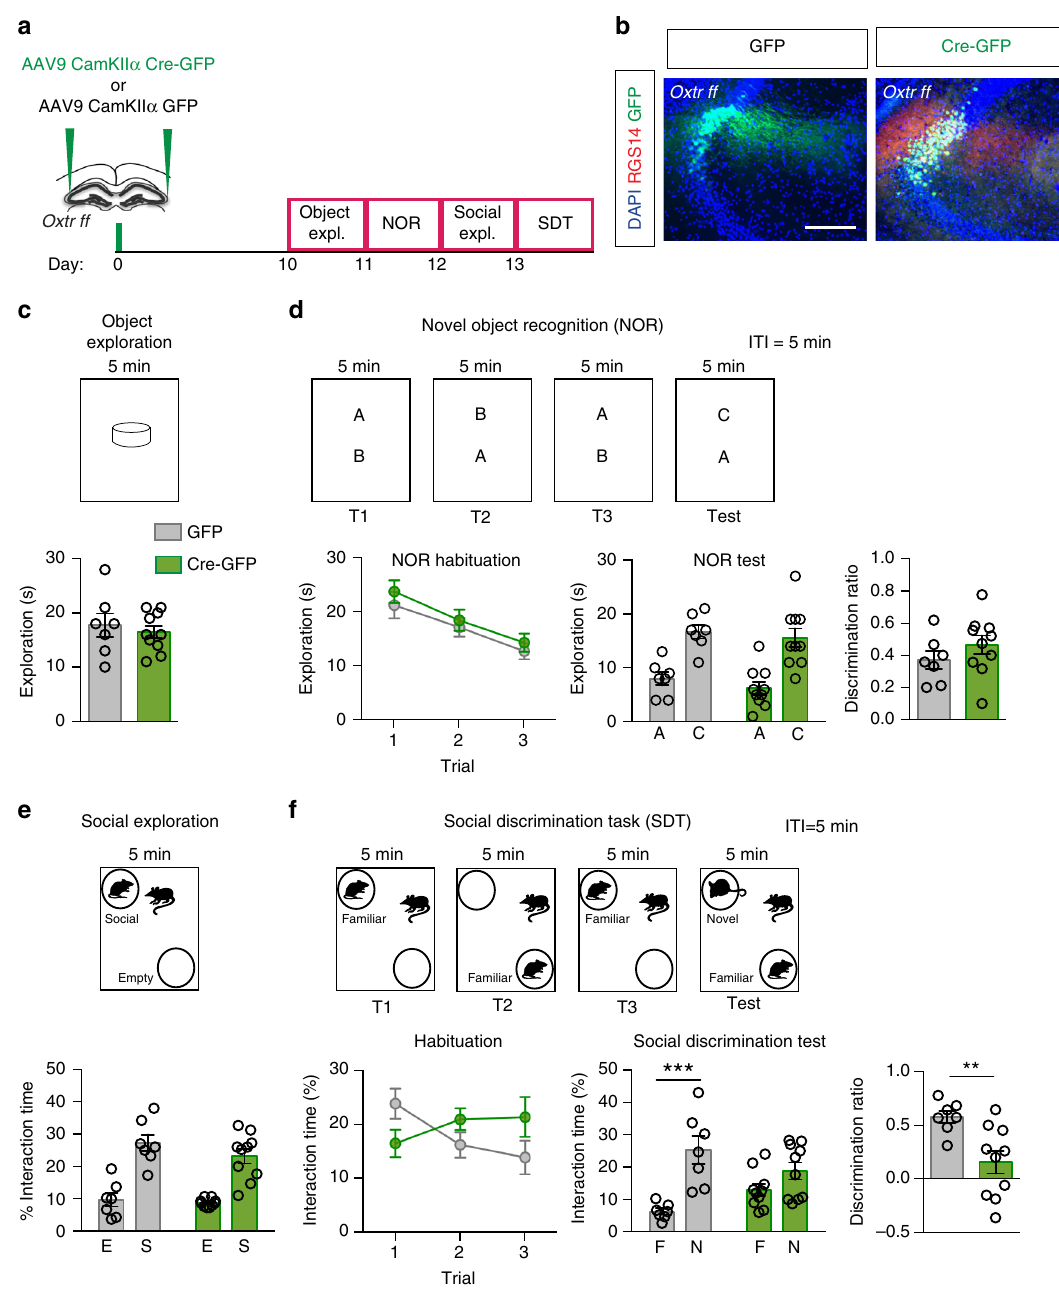
Fig. 3 Viral recombination of Oxtr in aCA2/CA3 distal impairs discrimination of social, but not non-social, stimuli. a Schematic illustrating viral injection and behavioral testing timeline. b Representative images of Cre and GFP virus infection in aCA2/CA3. Scale bar, 200 μ m. c Behavioral schematic (top) and quanti fi cation (bottom) of single object exploration (GFP: n = 7, Cre: n = 10). d Behavioral schematic (top) and quanti fi cation (bottom) of novel objection recognition (GFP: n = 7, Cre: n = 10). Quanti fi cations are displayed as Habituation (trials 1 – 3), Test (trial 4), and discrimination ratio (trial 4). e Behavioral schematic (top) and quanti fi cation (bottom) of social exploration test (GFP: n = 7, Cre: n = 10). f Behavioral schematic (top) and quanti fi cation (bottom) of social discrimination task (GFP: n = 7, Cre: n = 10). Quanti fi cations are displayed as Habituation (trials 1 – 3), Test (trial 4), and discrimination ratio (trial 4). All data are displayed as mean ±